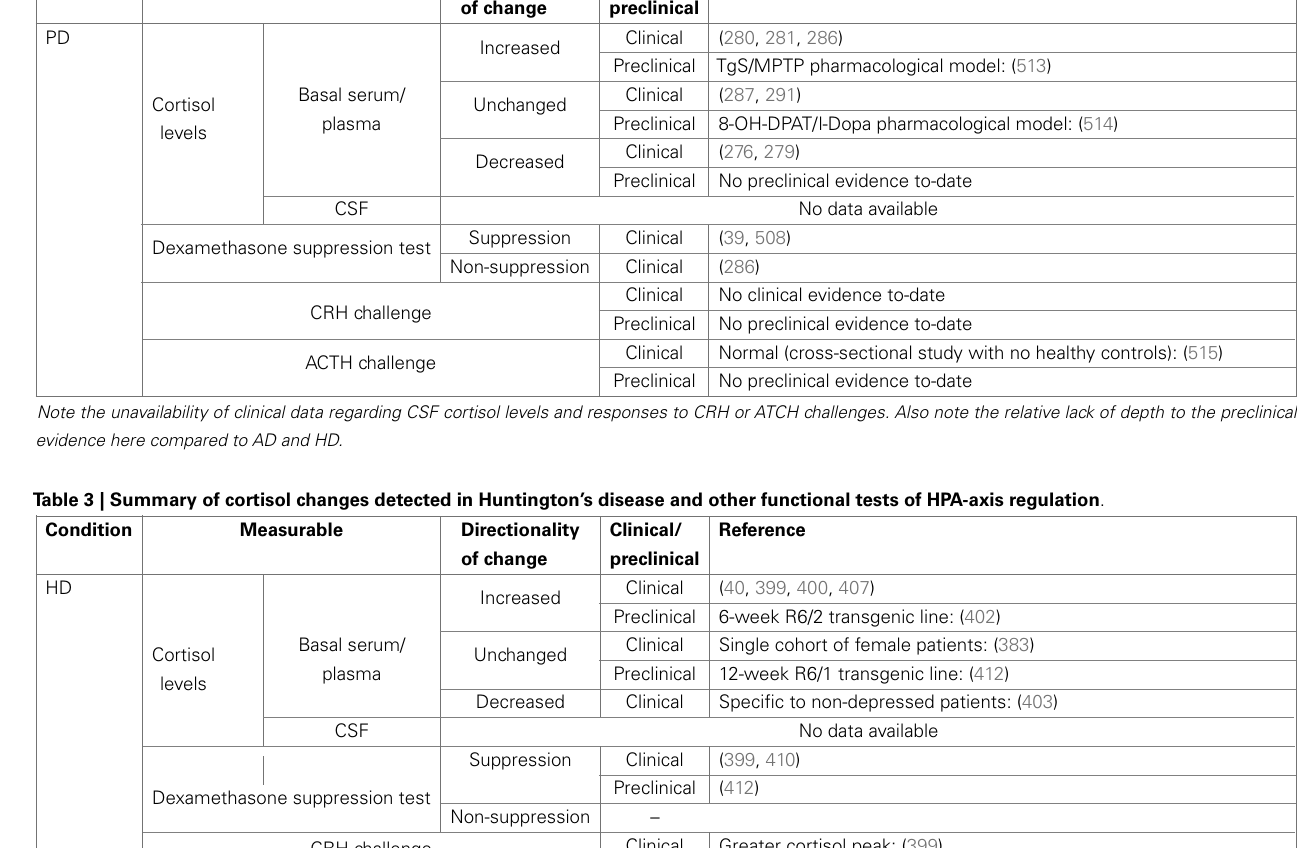
Table 2 | Summary of clinical and preclinical evidence for HPA-axis pathology in Parkinson’s disease . Condition